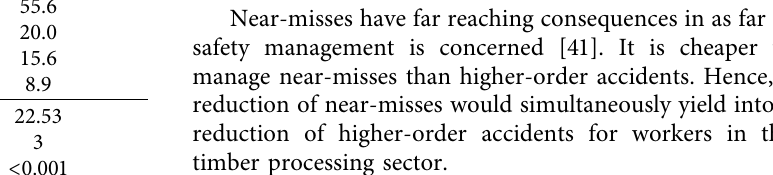
Table 2: Responses on level of accidents encountered or witnessed. Level of